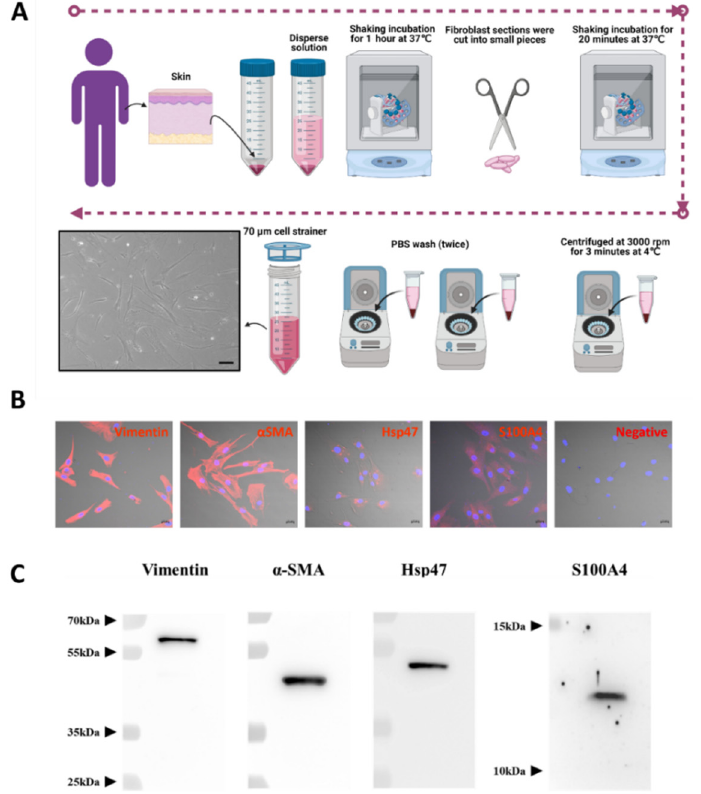
Figure 1. Successful isolation and characterization of normal fibroblasts from human skin. ( A ) Sche- matic diagram of the process used for isolating human NF (hNF) cells, created with BioRender.com (accessed on 11 August 2021) and phase-contrast imaging of hNF cells (lower left panel; scale bar: 20 µm). ( B ) Confocal microscopy of hNF cells probed with antibodies against fibroblast markers (vimentin, α -SMA, Hsp47, S100A4) and a secondary Alexa Fluor™ 555 antibody; for the negative indicated antibodies against fibroblast markers (vimentin, α -SMA, Hsp47,